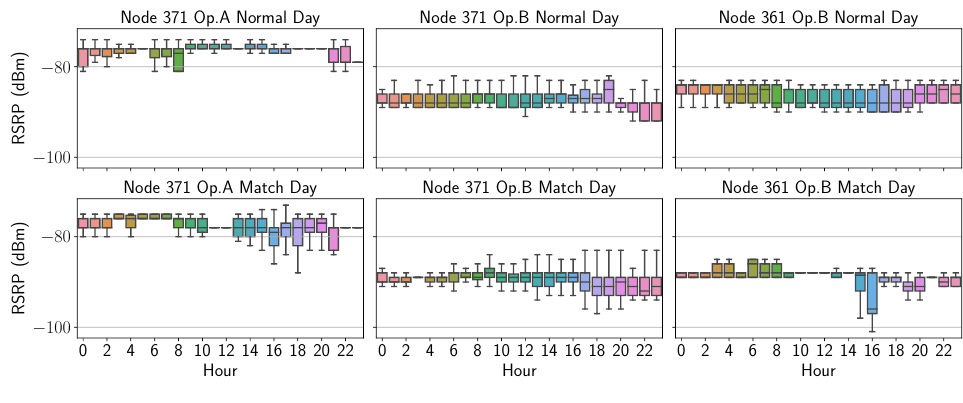
Figure 9. RSRP boxplot comparison.